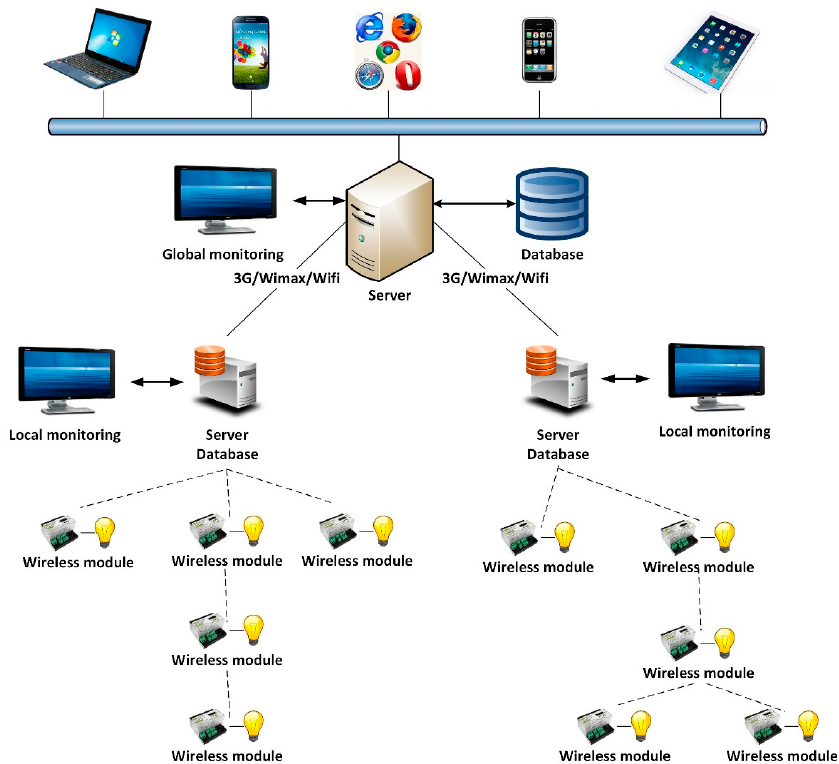
Figure 1. Architecture of the system.